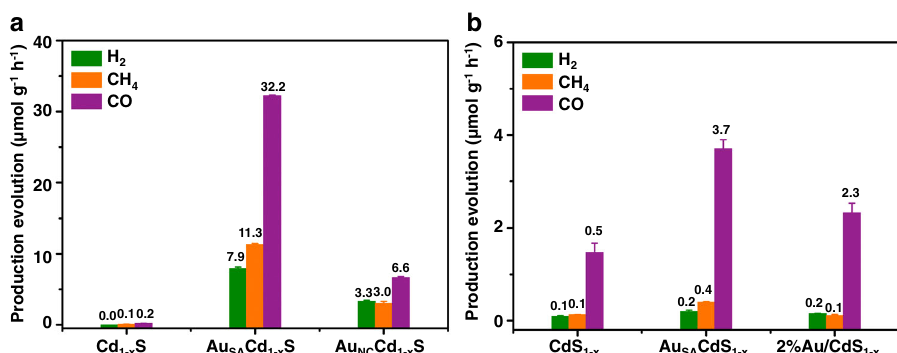
Fig. 3 The photocatalytic performance of CO 2 RR. Average yield in the photocatalytic conversion of CO 2 with H 2 O in the presence of water vapor under UV-visible light. a Over Cd 1-x S, Au SA /Cd 1-x S, and Au NC /Cd 1-x S samples. b Over CdS 1-x , Au SA /CdS 1-x , and 2%Au/CdS 1-x samples. The error bar was drawn based on the calculated standard error of two parallel